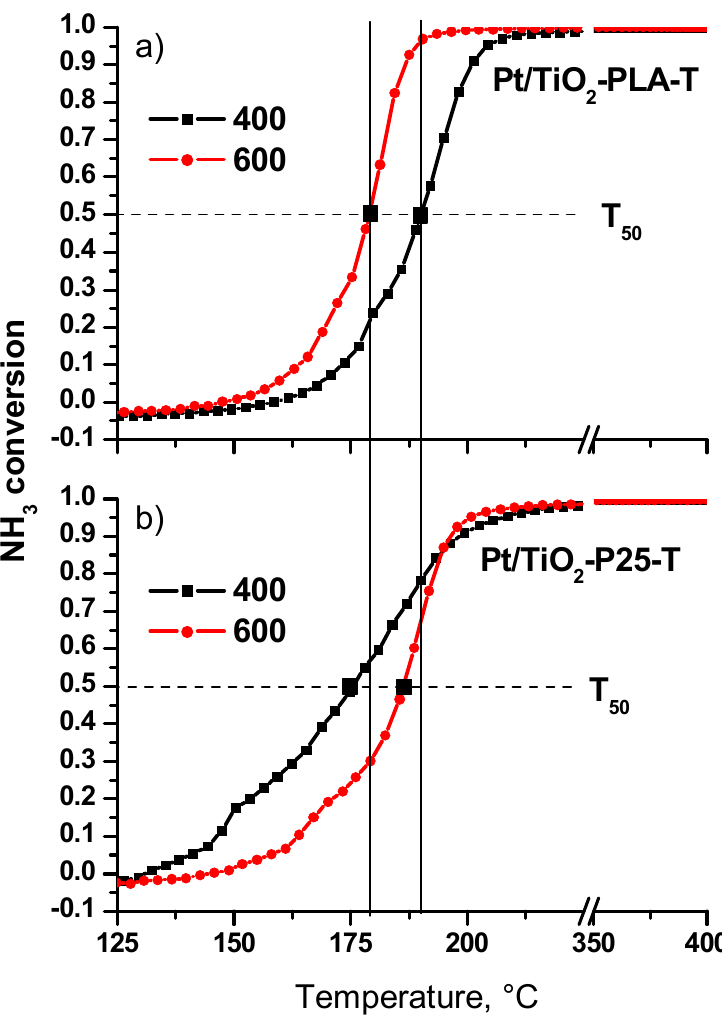
Figure 11. NH 3 conversion curves for the first catalytic cycle for the ( a ) Pt / Ti-PLA and ( b ) Pt / Ti-P25 catalysts calcined at 400 о С and 600 о С .